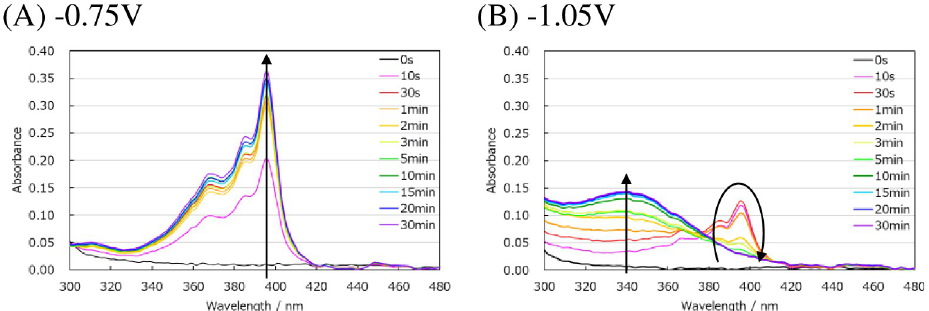
Fig 3. Absorption spectrum measured from 300 nm to 480 nm while applying voltage. (A) -0.75 V. (B) -1.05 V. Voltage application time 0 s—30 min. These experiments were repeated three times with similar results.